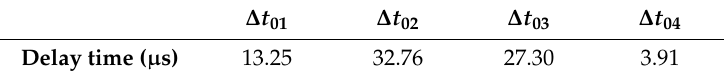
Table 1. Delay time for transducers at P1–P4 with P0 excitation.